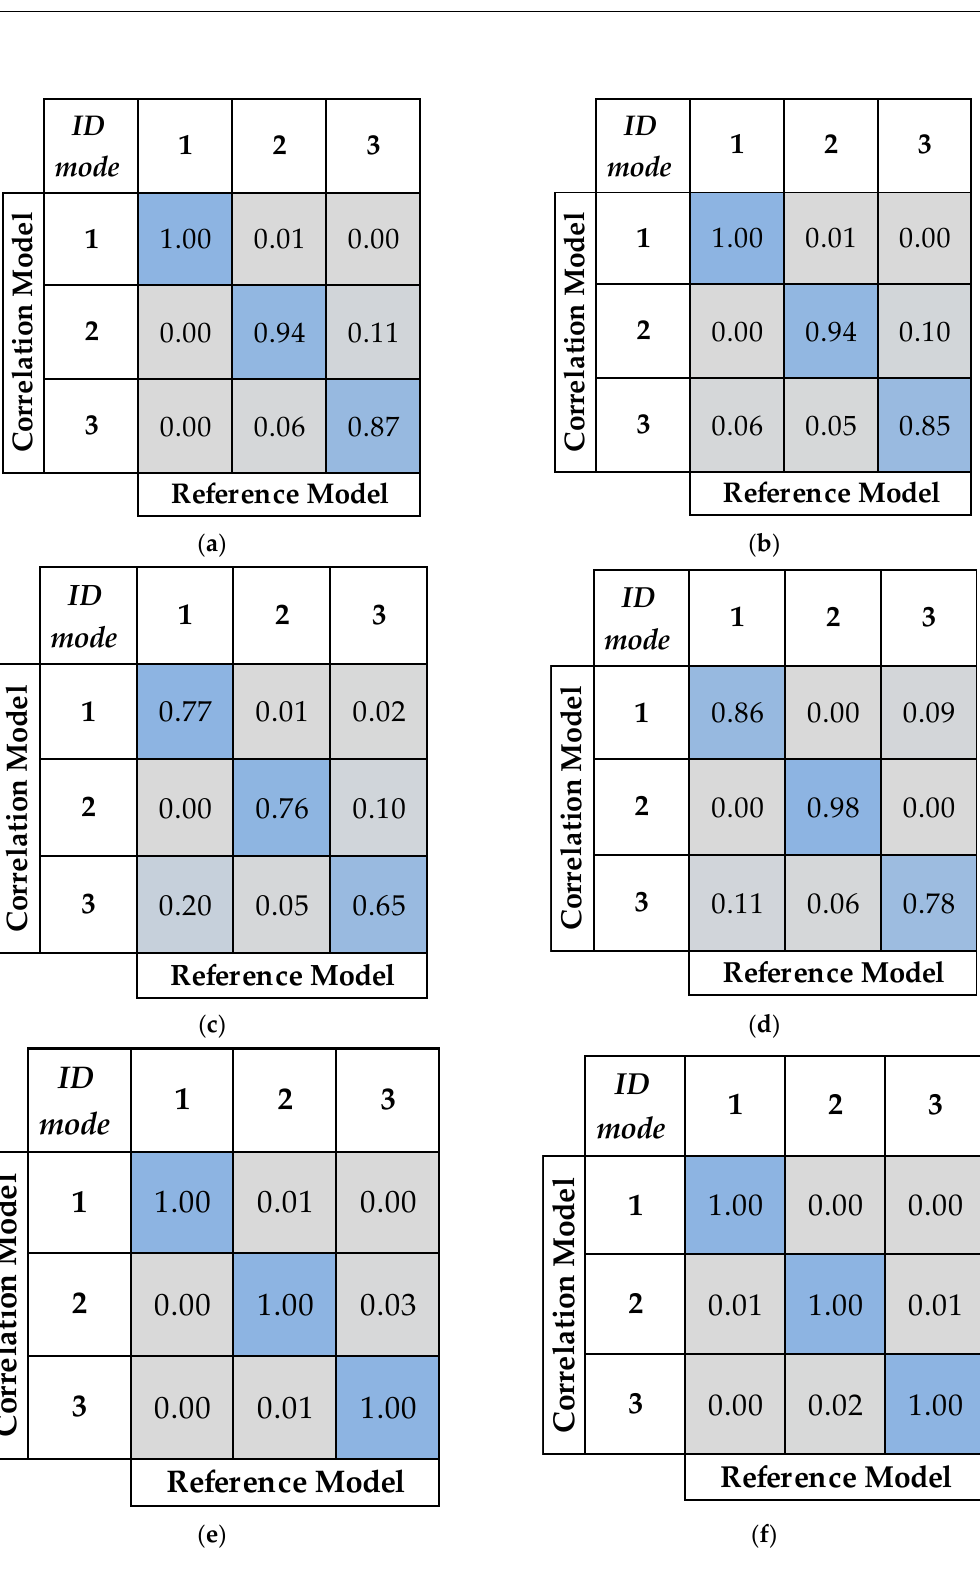
Figure 16. Mode shape orthogonalization verification with respect to the baseline configuration: ( a ) 0.5 kg on each side; ( b ) 1 kg on the forward corner; ( c ) 1 kg on the aft corner; ( d ) pushrod link failure; ( e ) pulling down aero pressure; and ( f ) pushing up aero